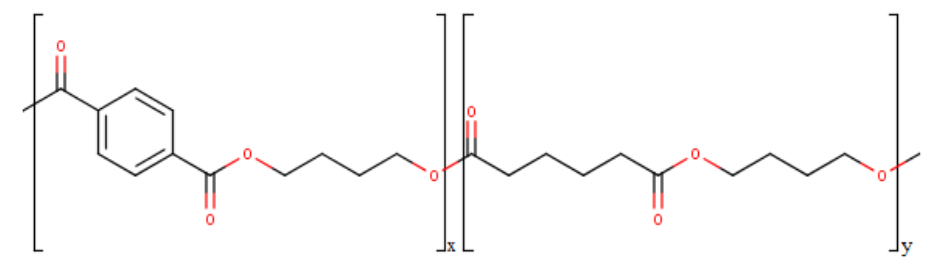
Figure 1. Structure of polybutylene adipate terephthalate (PBAT).